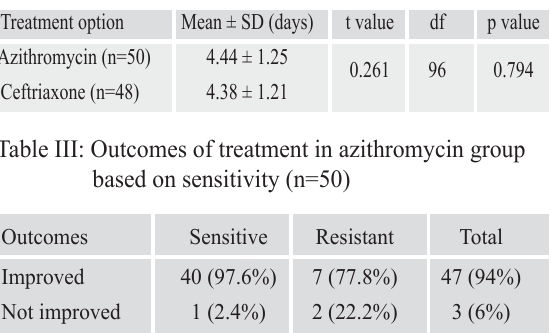
Table II: Time of defervescence in study subjects in days (n= 98)